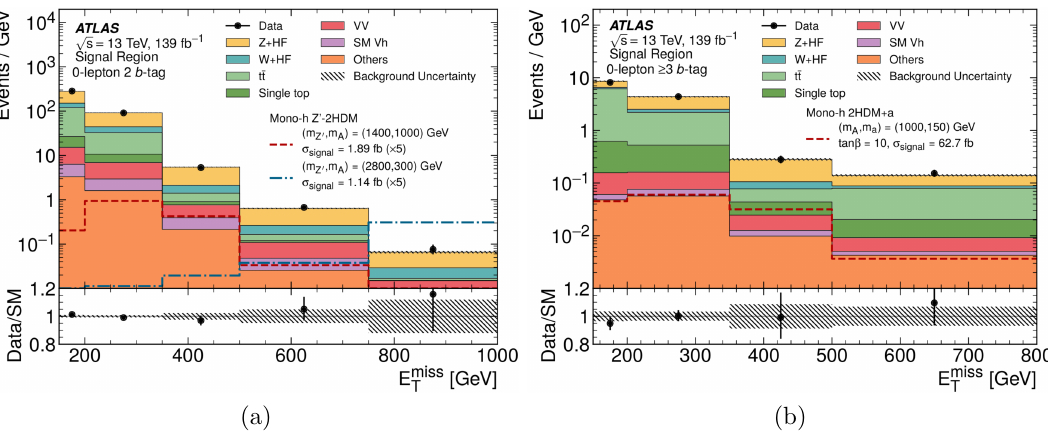
Figure 6. E miss distributions after requiring (a) two b -tagged jets or (b) at least three b -tagged T jets. The background yields are obtained in a background-only fit to data. Each bin corresponds to one signal region, where the bins at lower E miss use small- R jets and the ones with larger E miss T T select events with at least one large- R jet. The rightmost bin includes all events with E miss above T the range shown on the plots. The bottom panel compares the data with background estimates as obtained from the fit. Example signal models are overlaid in the top panel. In plot (a) two Z 0 -2HDM points are shown, one with parameters ( m Z 0 , m A ) = (1400 GeV , 1000 GeV ) and a cross-section of 1.89 fb and the other with parameters ( m Z 0 , m A ) = (2800 GeV , 300 GeV ) and a cross-section of 1.14 fb. Both signals are scaled up by a factor of 5 for better visibility. In plot (b) a 2HDM+ a is shown with parameters ( m A , m a ) = (1000 GeV , 150 GeV ) , tan β = 10 and a cross-section of 62.7 fb.